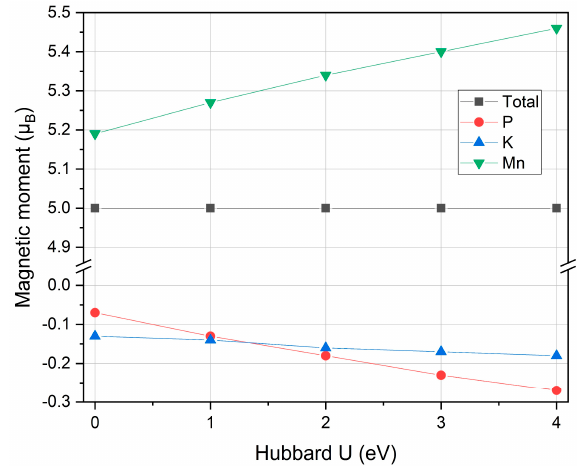
Figure 4. The calculated total and partial magnetic moments under different Hubbard U values for the half Heusler compound MnPK.